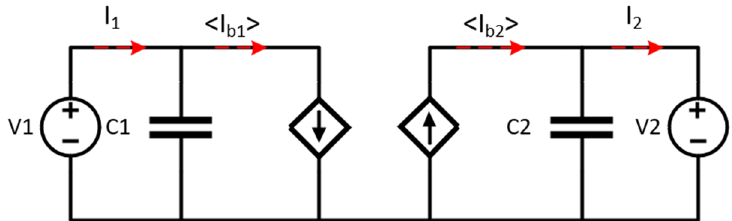
Figure 5. Dual active bridge topology ( a ), high-frequency voltage waves, and resulting current ( b ).